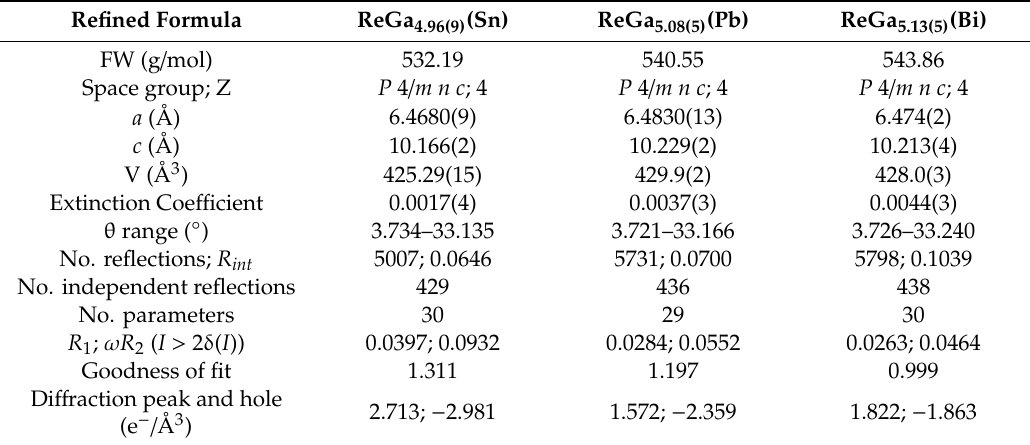
Table 1. Single crystal refinement data for ReGa 4.96 (Sn), ReGa 5.08 (Pb) and ReGa 5.13 (Bi).